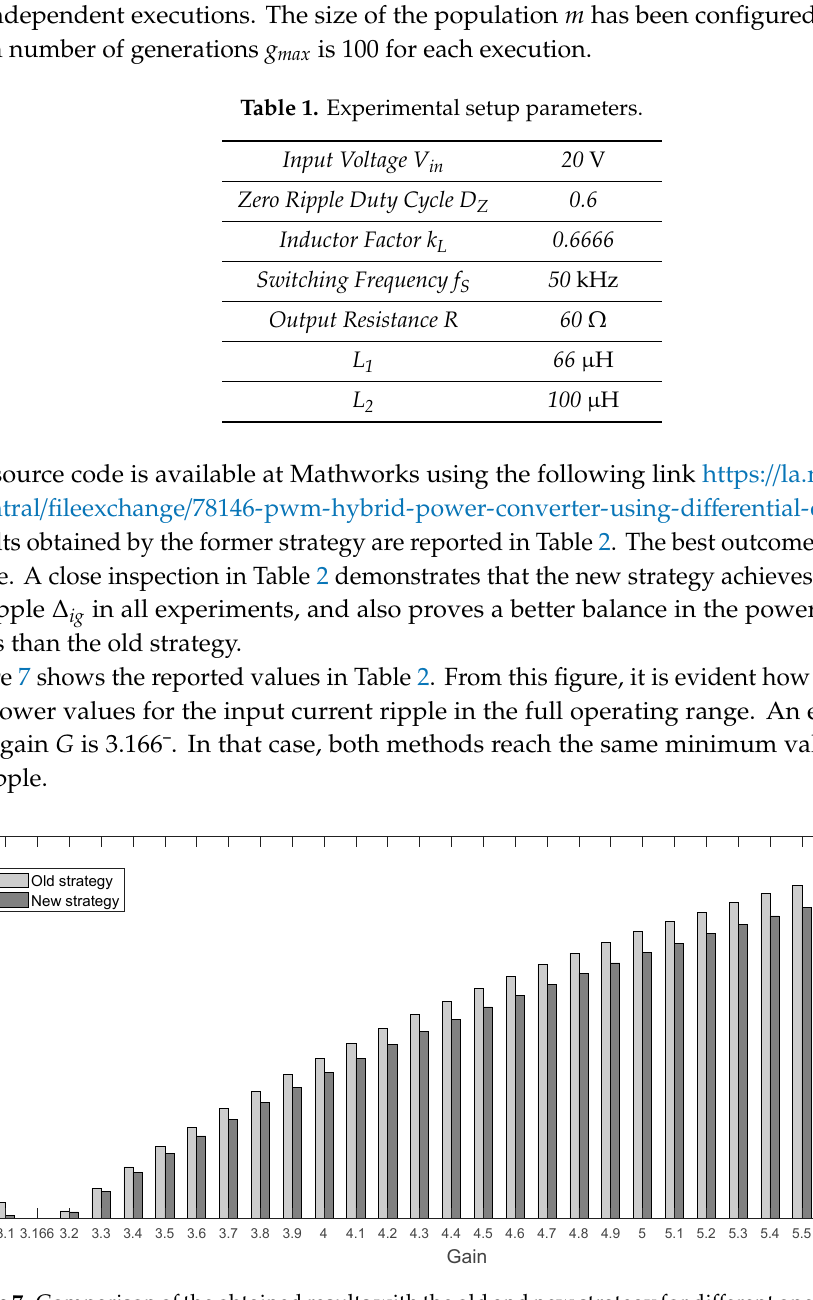
Figure7. Comparisonoftheobtainedresultswiththeoldandnewstrategyfordi ff Figure 7. Comparison of the obtained results with the old and new strategy for different operation points.